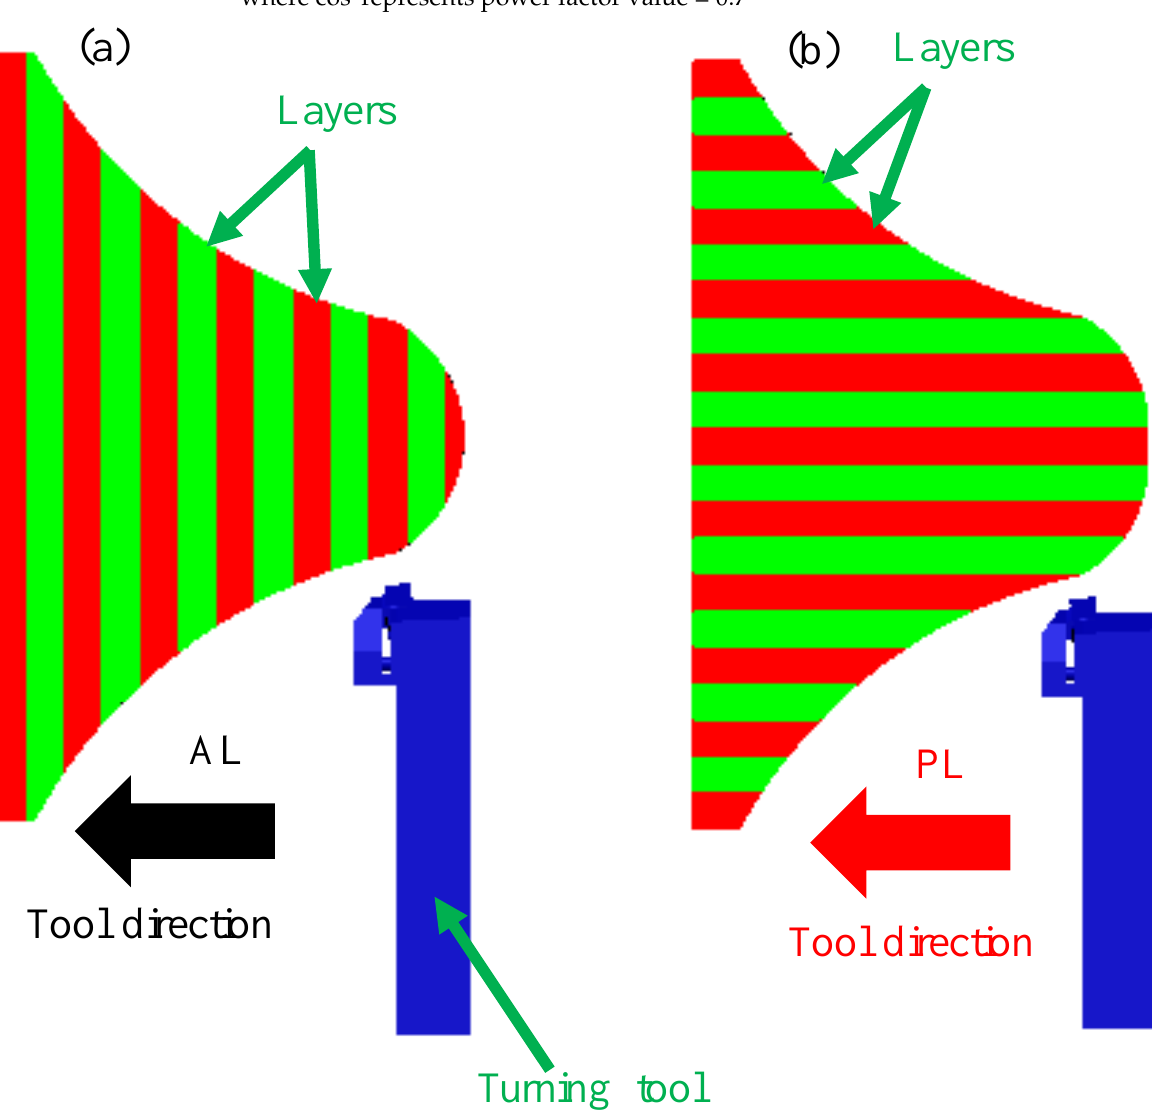
Figure 2. A simplified illustration of the various part orientations possible while turning an EBM: ( a ) across Layer (AL); ( b ) parallel Layer (PL). Table 3. Turning process parameters.